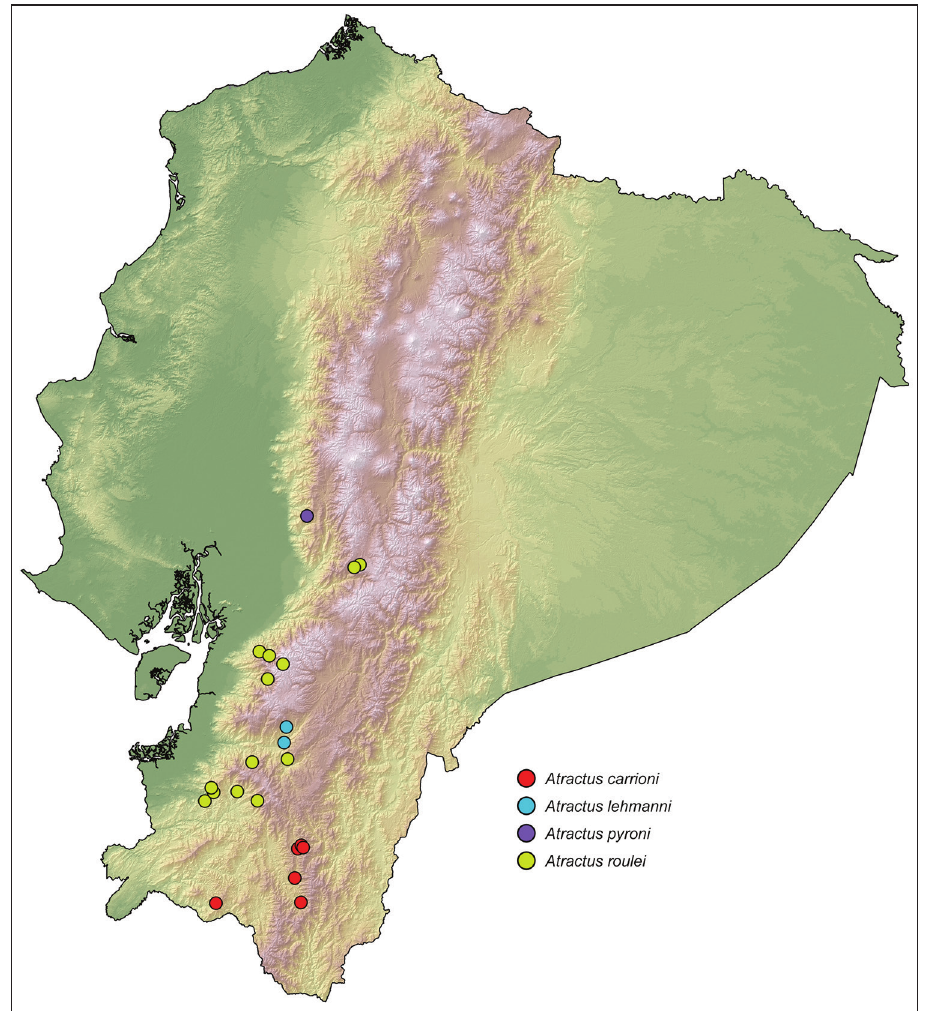
Figure 4. Distribution of Ecuadorian snakes of the Atractus roulei species group. Dots represent known